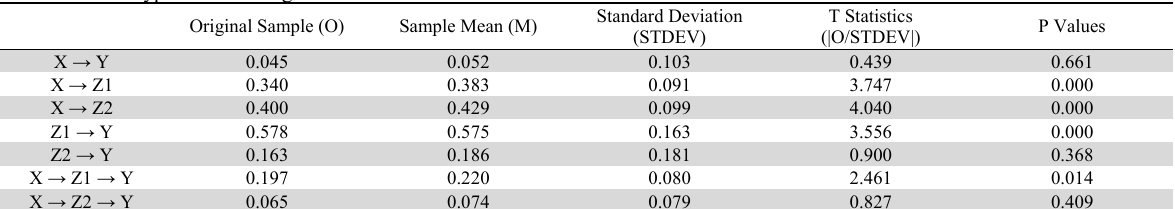
Table 7 Final Result of Hypothesis